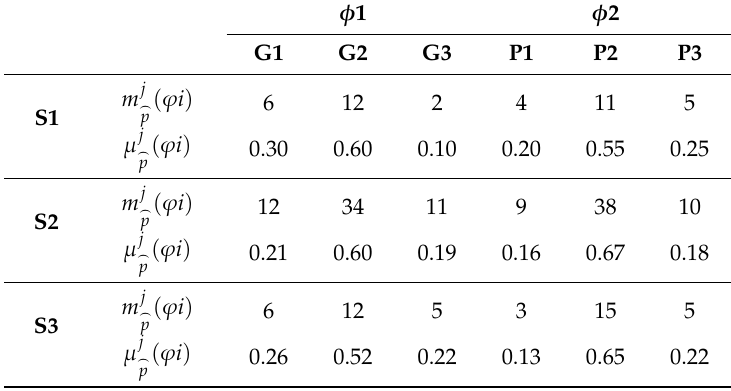
Table 1. Three spatial entity attribute membership degree comparison